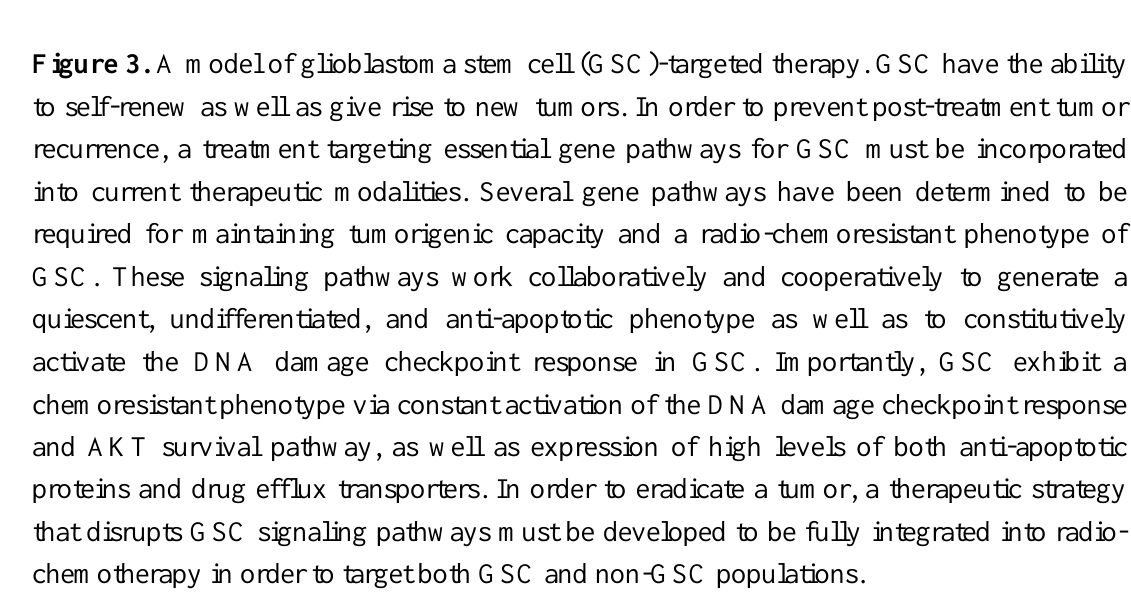
Figure 3. A model of glioblastoma stem cell (GSC)-targeted therapy. GSC have the